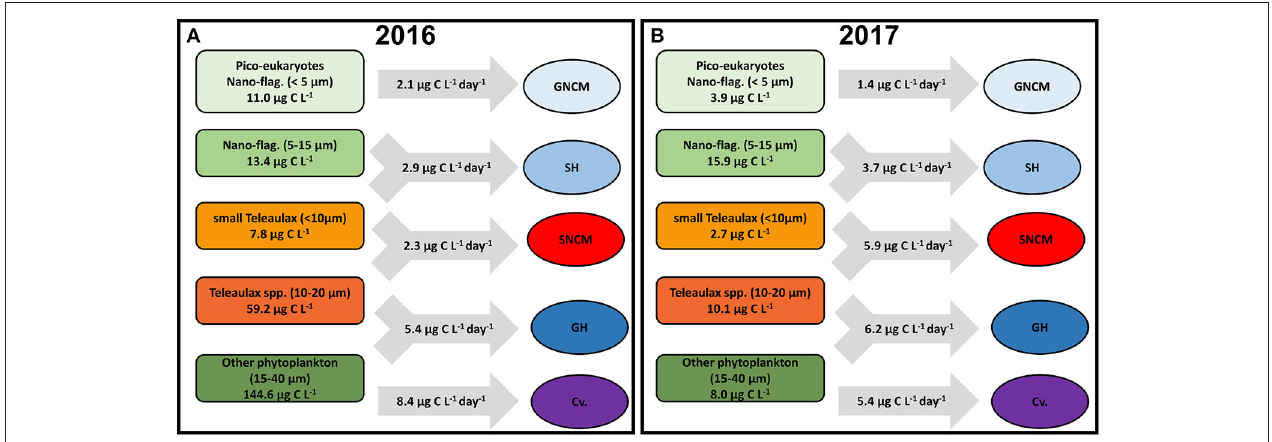
FIGURE 7 | Simplified scheme showing the daily average biomass of each phytoplankton prey group and the average grazing rates of each ciliate trophic strategy in 2016 (A) and 2017 (B) . Averages calculated only for the productive season (March to